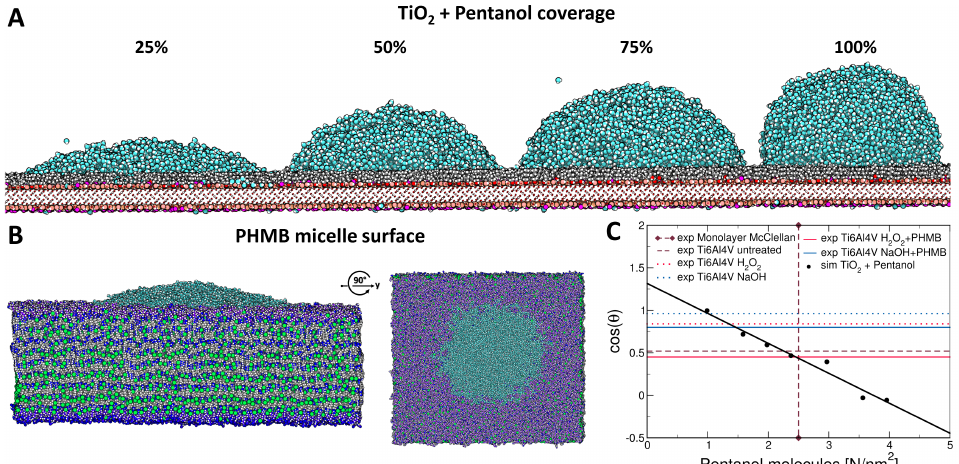
Figure 4. ( A ) Snapshots near the end of water contact angle simulations on TiO 2 slabs with increasing pentanol coverage. The percentages of 25%, 50%, 75% and 100%, denote the coverage remaining, after randomly removing pentanol molecules from the simulated equilibrium coverage and this assigns to 0.99, 1.98, 2.97 and 3.96 pentanol molecules per nm 2 , respectively. The titanium dioxide crystal is represented by smaller atoms (O: red; Ti: pink). Hydroxylation groups and sodium ions on the top and bottom interfaces are drawn as bigger atoms (O: orange; H: white; Na + : magenta). The pentanol molecules (C: grey; O: red) sit on top of the TiO 2 surface with their OH − group pointing downwards. The water droplet on top (O: cyan), builds different contact angles with the slab and this depends strongly on the hydrocarbon contamination level. ( B ) (left) Illustrative snapshot of WCA simulations on pure PHMB surfaces as excerpts of larger micelles with brush-like aggregation of polymer strands. The PHMB oligomers (C: grey; N: blue; Cl − : green) stand upright with the PHA and PHT end-groups at the bottom and top, respectively. To differentiate the end-groups visually from the main chain repeat PHM, the carbon atoms of PHA and PHT are colored in different purple shades. (right) Top view. C . Results from simulated WCA on pentanol-coated titanium dioxide